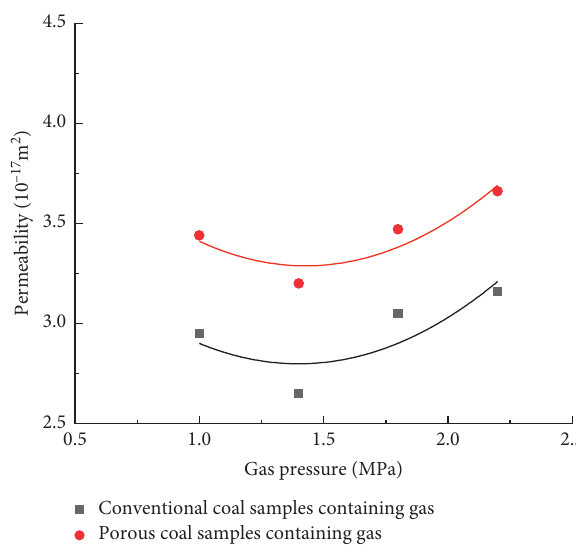
Figure 6: Changes of permeability of conventional and porous gas-bearing coal samples. Table 2: Acoustic emission parameters of porous and conventional gas-bearing coal samples under different confining pressures and gas pressures.